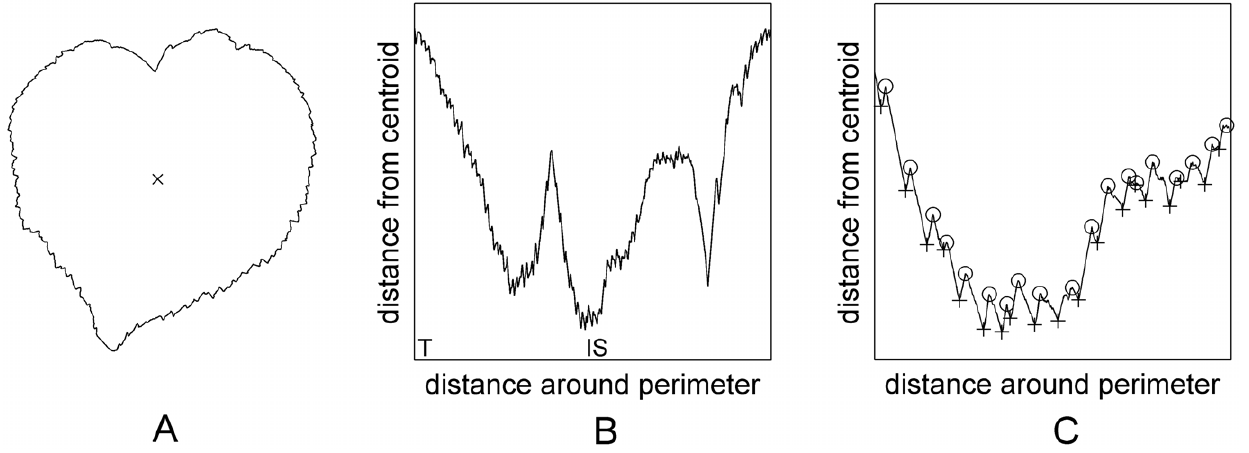
Figure 2. Centroid-contour plots. A) The outline of a single leaf with the centroid marked. B) The centroid-contour plot for the same leaf. The left side of the plot corresponds to the leaf tip (marked ‘T’) and moves clockwise around the leaf through the insertion point at the top of the leaf (marked ‘IS’) and back to the tip at the right hand side. C) A detail of the centroid-contour plot around the insertion point. Here, individual teeth tips are marked by our software with a circle and each sinus is marked with a cross.